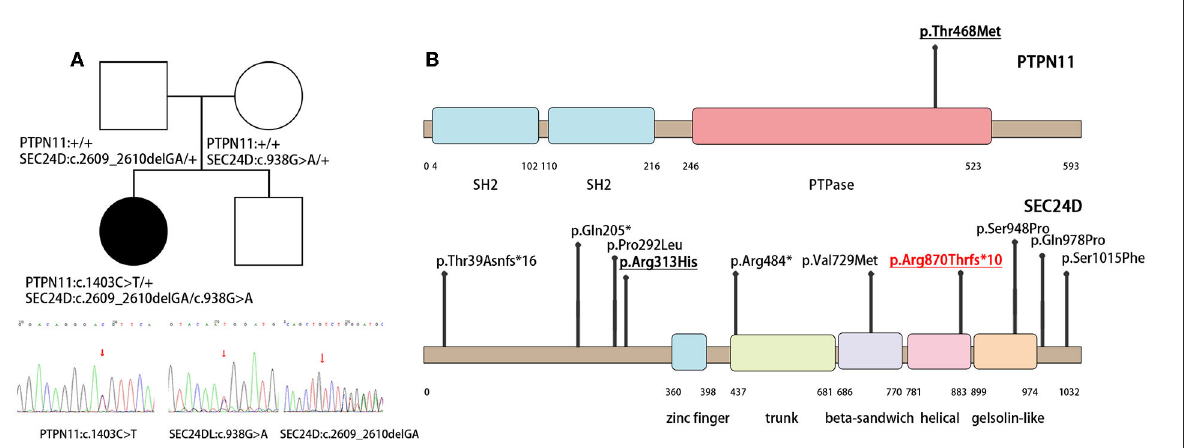
FIGURE2 Family of the affected child and illustrations denoting the mutant sites. (A) The PTPN11 and SEC24D mutation and the results of the patient’s whole-exon sequence. (B) Illustrations denoting the mutant sites. Previously found varients in patients with Cole-Carpenter syndrome-2 are depicted in black. The variants found in our patient is underlined and p. Arg870Thrfs*10 in red is the novel variant.